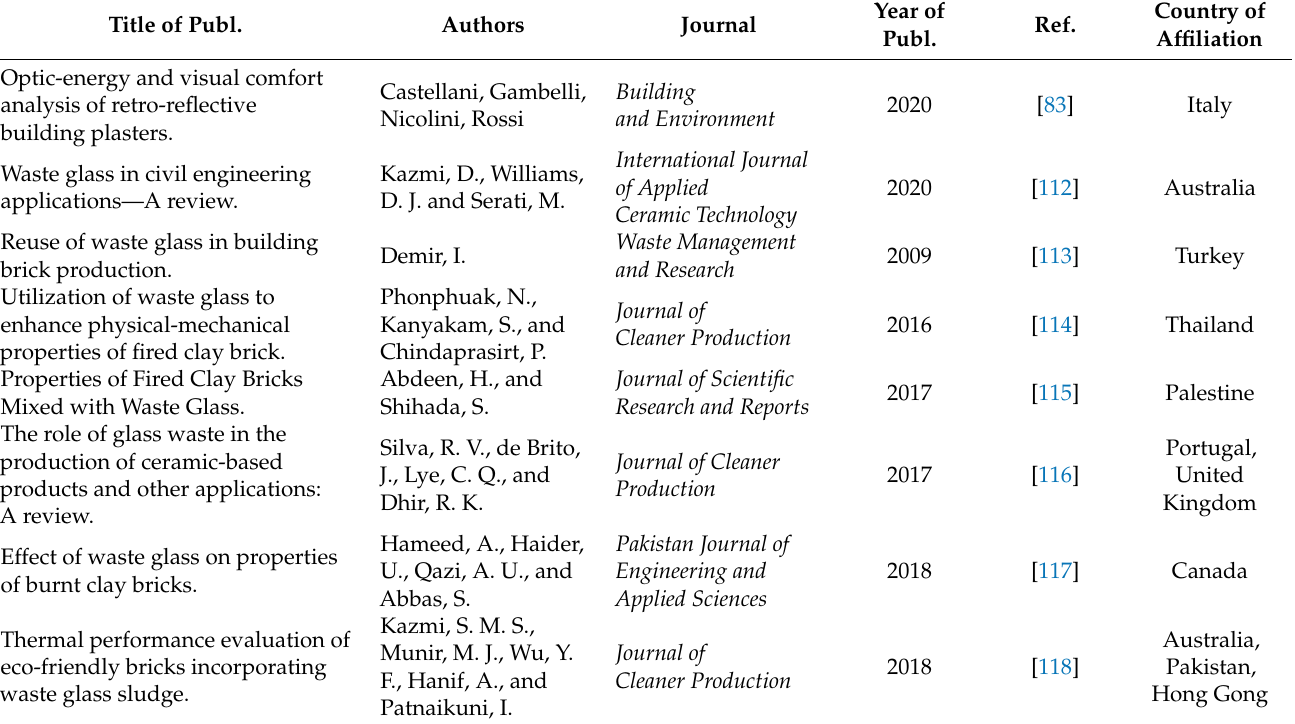
Table 5. Most important publications about